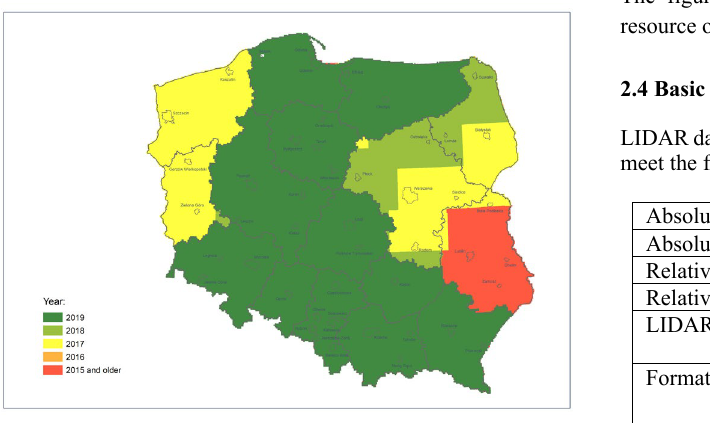
The figure 2. Planed state of 25 cm orthophotomaps in national resource on the end of 2019 year